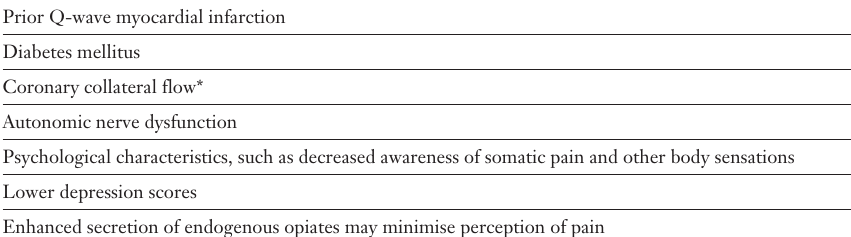
Factors favouring the development of silent myocardial ischaemia in a general